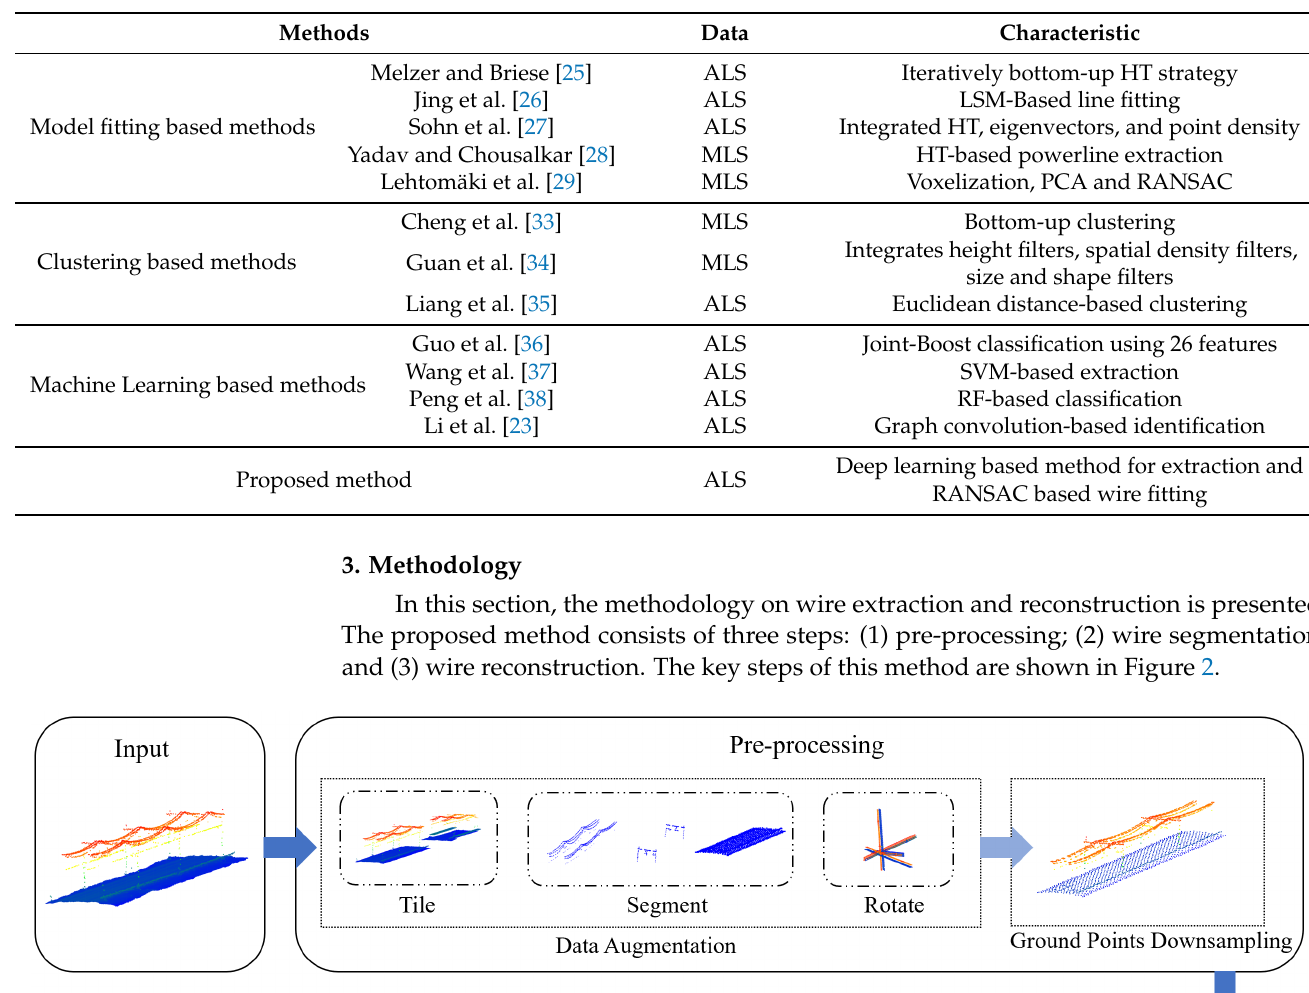
Table 1. Summary of powerline extraction methods.